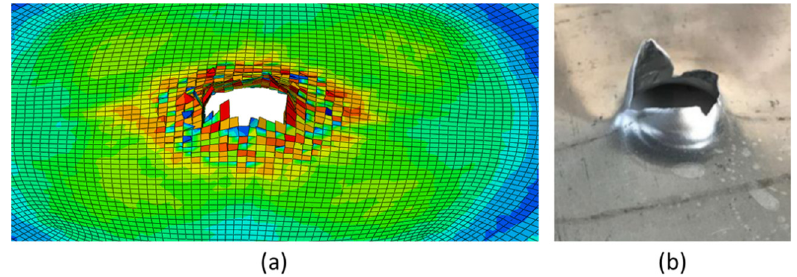
Figure 5: Validation results: ( a ) stress distribution numerical analysis ( b ) experimental result of monolithic target for 0° obliquity and 107.7 m/s velocity conducted by [ 16 ]